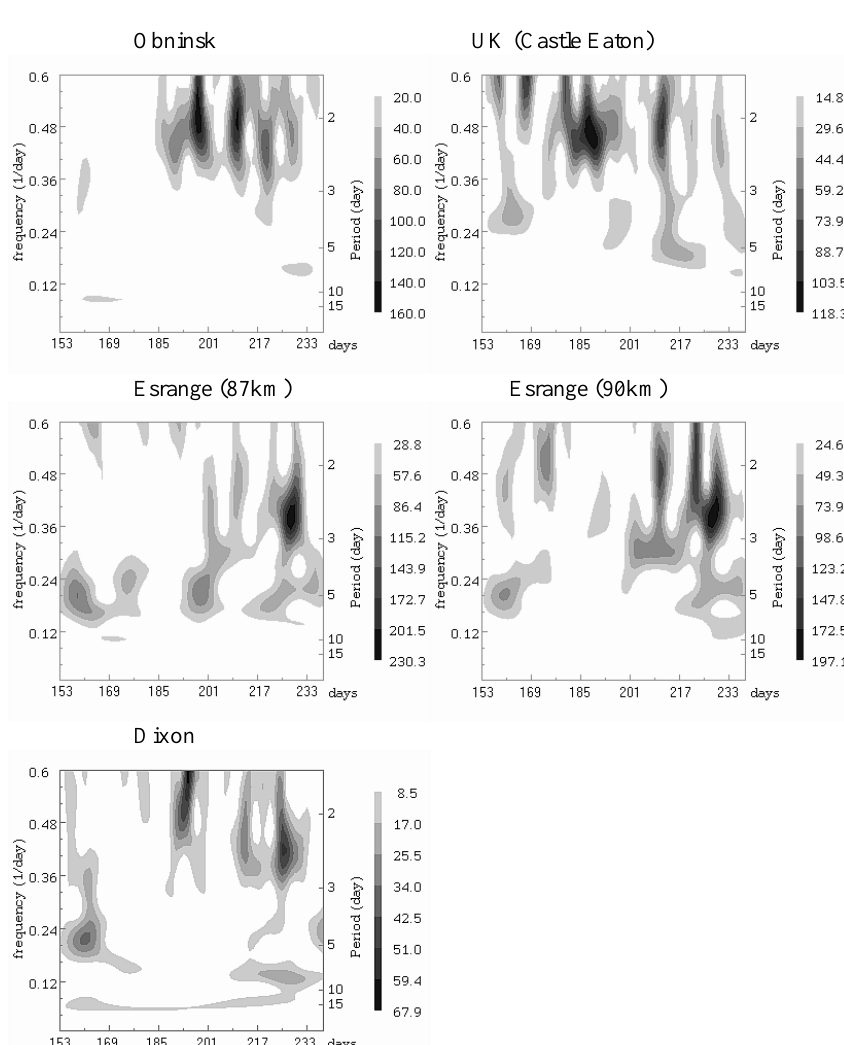
Fig. 2. S-transform spectra of the zonal wind variations with periods near 2